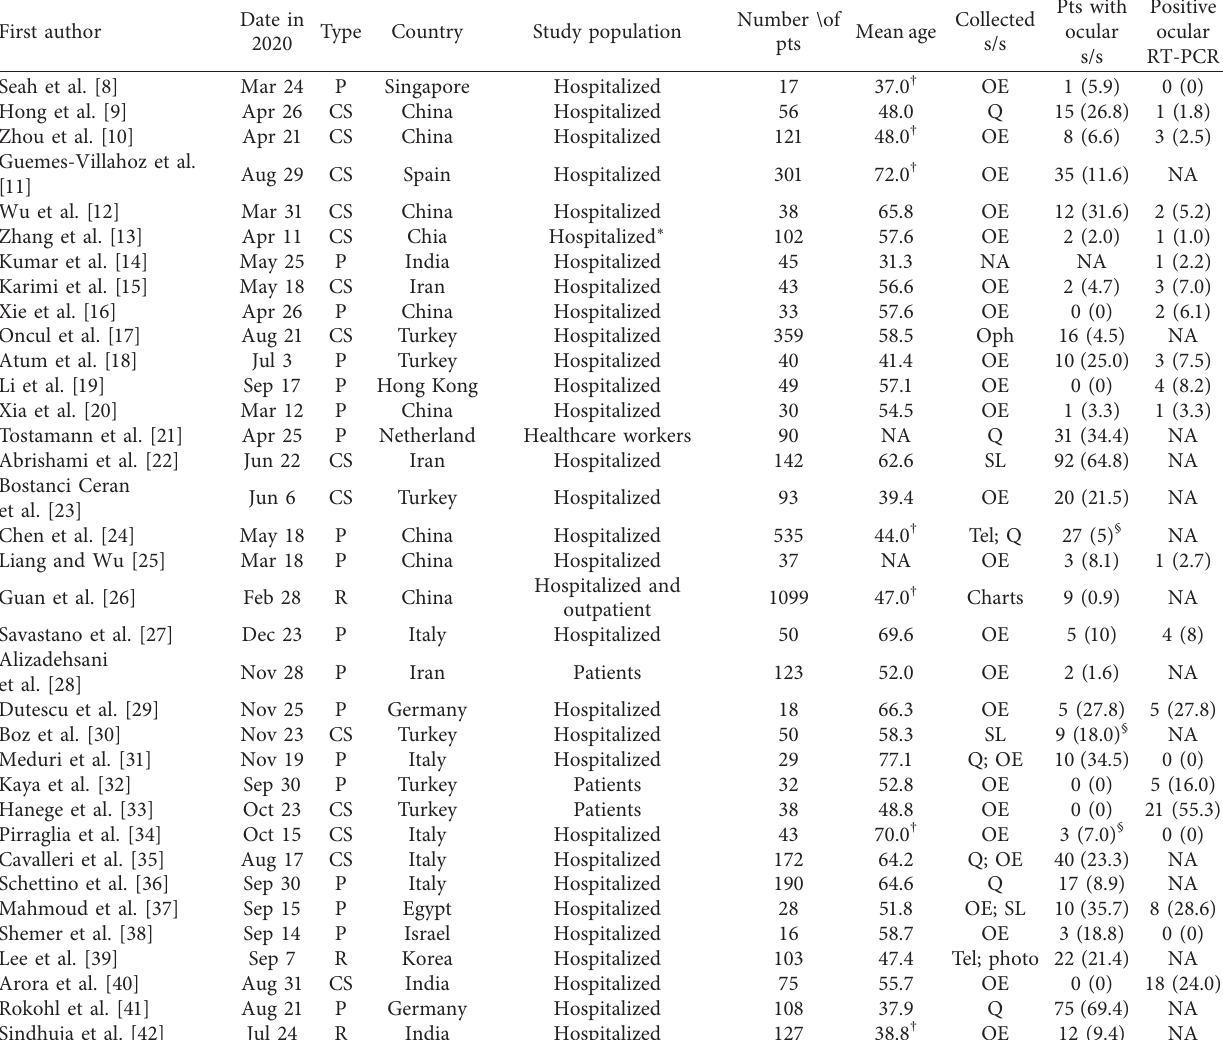
Table 2: Characteristics of patients in studies included in the